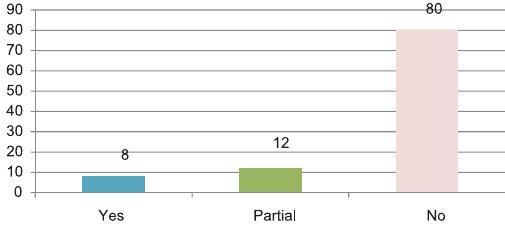
FIGURE 7. Respecting opinions and suggestions by the man- agers (head, chief nurse)